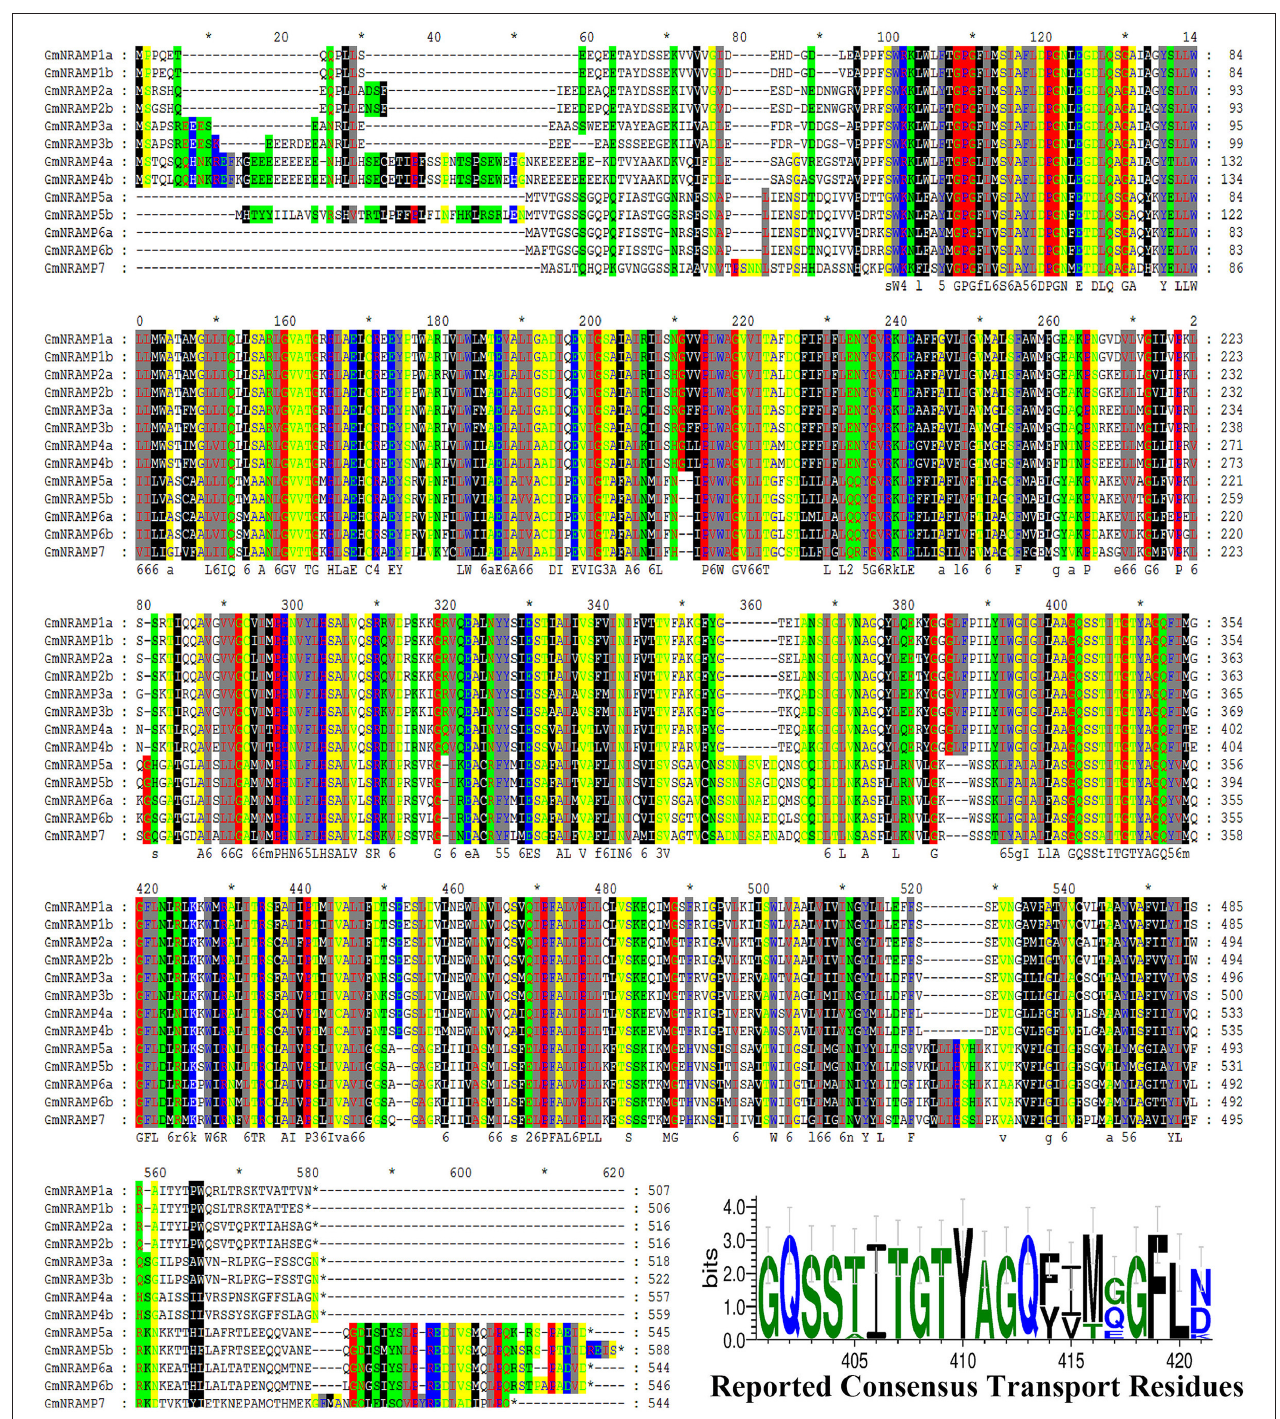
FIGURE 2 | Multiple alignment of soybean NRAMP family proteins. Multiple alignment was performed with Clustal W and the residues were colored using Genedoc software. Red lines underneath alignments indicate reported consensus transport residues. “*” above the sequence mean every ten amino acid residues. The logo of these residues was then generated in WebLogo 3